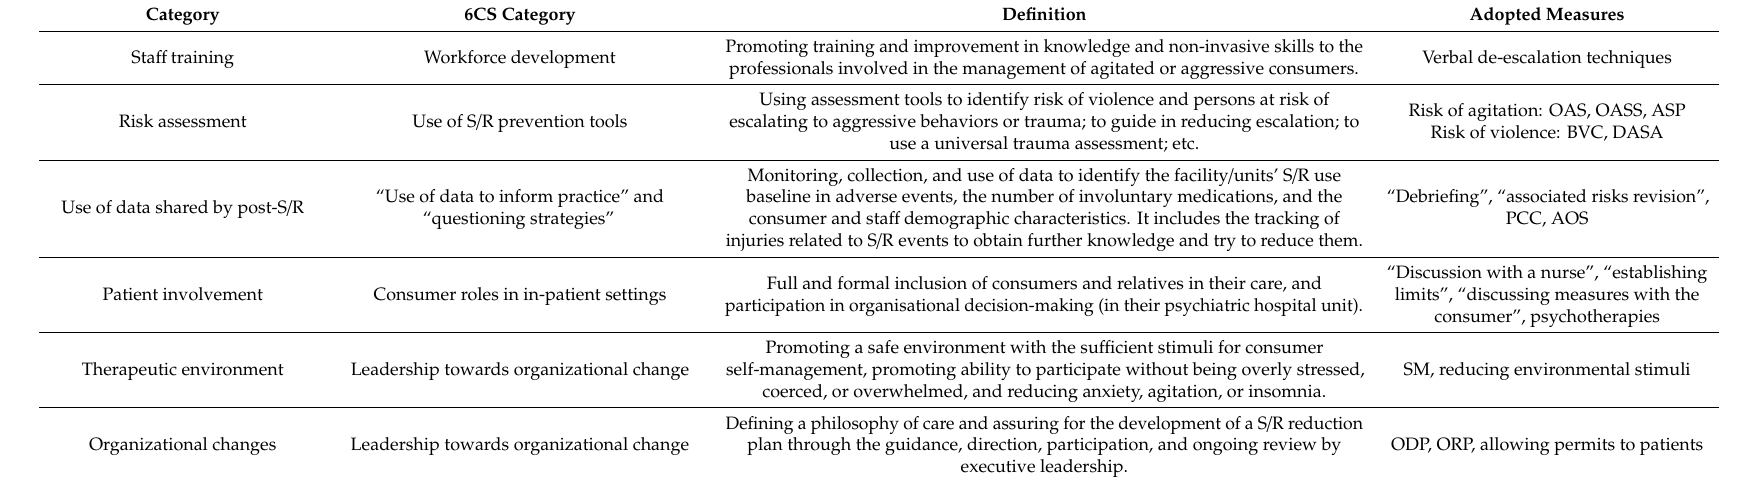
Table 3. Identified simple interventions and their correspondence with 6CS ( Six Core Strategies to reduce seclusion and restraint use) [37].